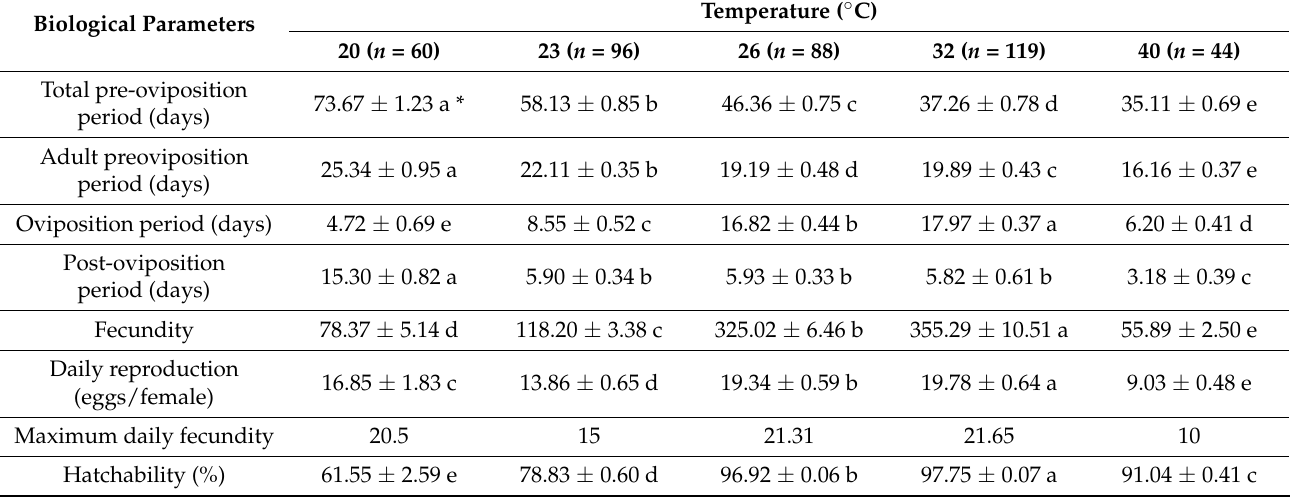
Table 3. Pre-oviposition, oviposition, post-oviposition, fecundity, daily reproduction (eggs/female) and Hatchability (%) of D. opuntiae under different constant temperatures (20, 23, 26, 32, and 40 ◦ C) (mean ±